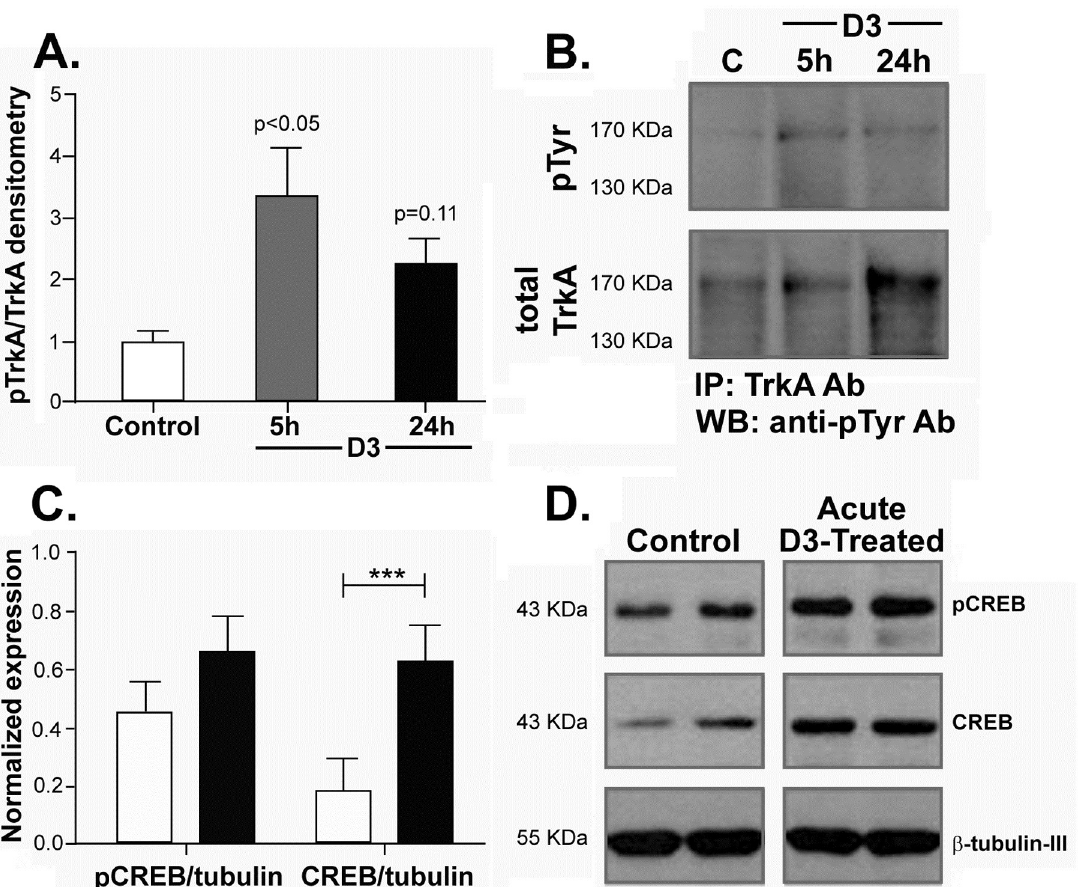
Fig 2. Acute D3 increases TrkA phosphorylation and CREB in the hippocampus. (A) Densitometric quantification of Western blots shows a significant increase in pTrkA in the hippocampus at 5 hours (p < 0.05, n = 3) and a trend at 24 hours (p = 0.11, n = 2), compared to vehicle (n = 3). ( B ) Representative Western blots of samples immunoprecipitated with TrkA antibody and blotted with phospho- tyrosine antibody 4G10. Protein was extracted from the hippocampi of mice sacrificed at the times indicated. (C) Densitometric analysis shows a significant increase in CREB (p < 0.005) at the 24-hour time point after treatment with D3 (n = 4) compared to vehicle (n = 3). (D) Representative Western blots of protein extracted from the hippocampi of mice sacrificed at the times